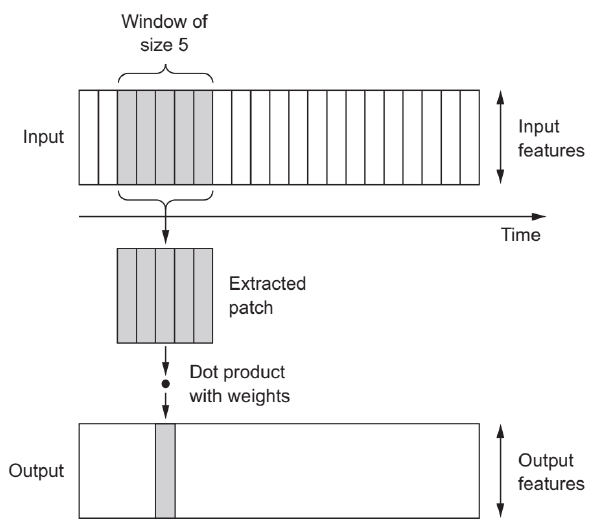
Figure 6. CNN 1D operations for sequential and time series data. Adapted from Chollet et al. (2015).